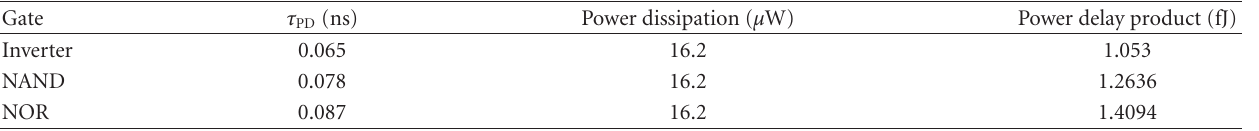
Table 1: CMOS Tristate gates.